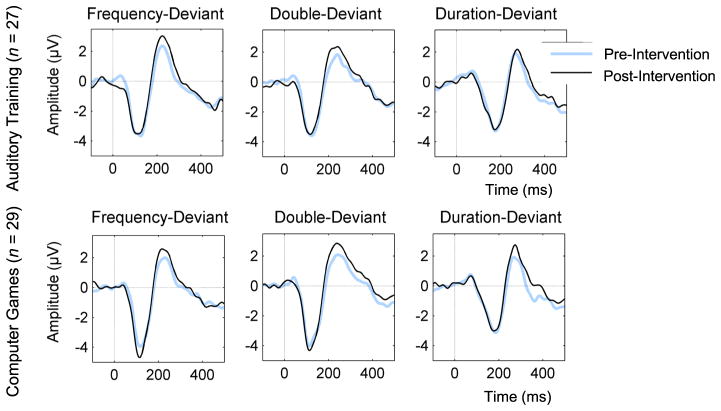
Mismatch Negativity (MMN) Amplitudes For Each Treatment Group And Deviant Type Before And After The Intervention. Ear-referenced ERP difference waveforms averaged across electrodes Fz, Fz, F4, C3, Cz, C4 for Duration, Double (duration + frequency), and Frequency MMN are given for Auditory Training (AT) participants (top) and Computer Games (CG) participants (bottom). Baseline MMN amplitudes are shown in blue, post-intervention MMN amplitude are shown in black